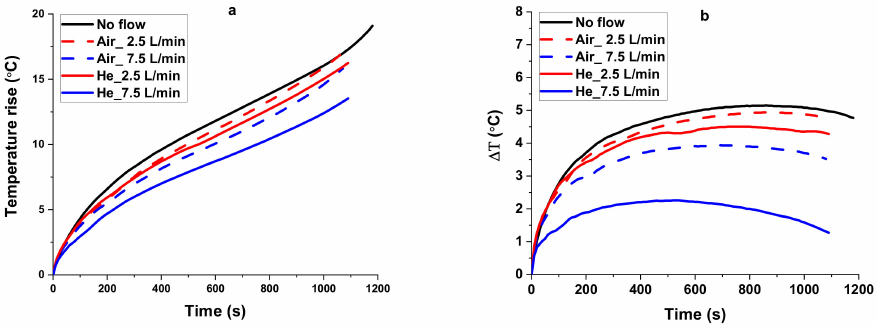
Figure 7. ( a ) The change on the maximum temperature ( ∆ T 1 ), and ( b ) the temperature gradient ∆ T (T 1 − T 3 ) on cell surface.